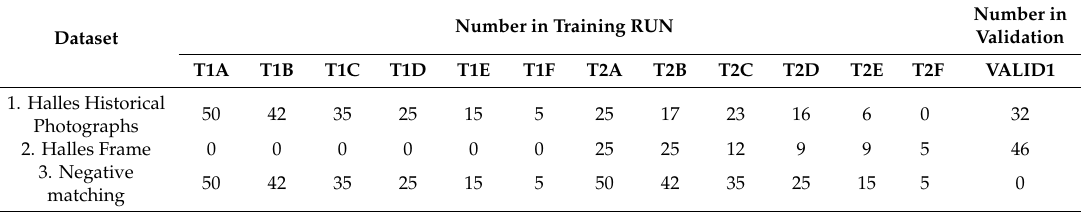
Table 5. Description of the training and validation dataset 3 on the real case of Les Halles. Dataset